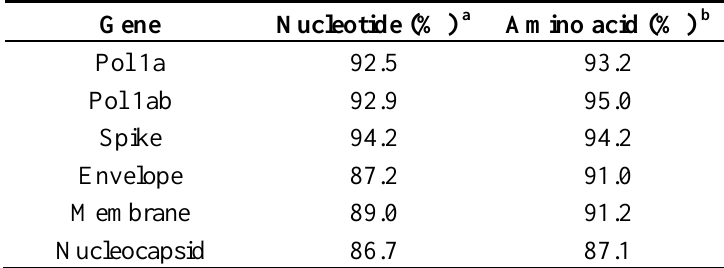
Table 1. Comparison of ACoV and HCoV-229E individual gene